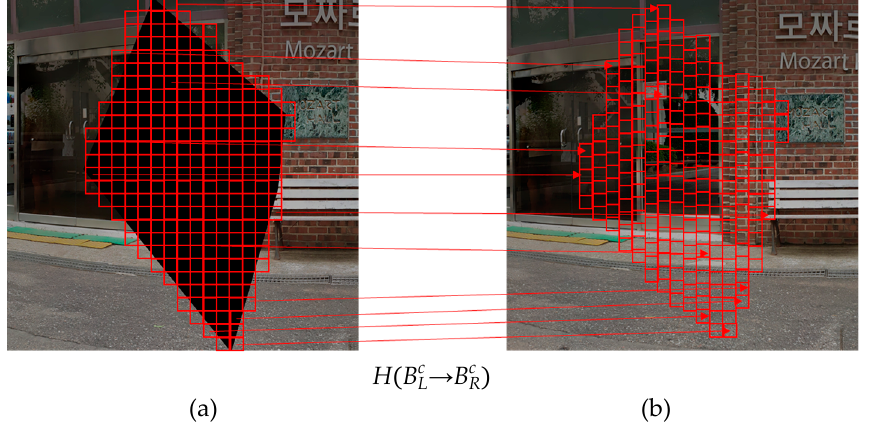
Figure 5. Concealment process based on derived homography matrix: ( a ) A part of the left ERP; ( b ) A part of the right ERP.